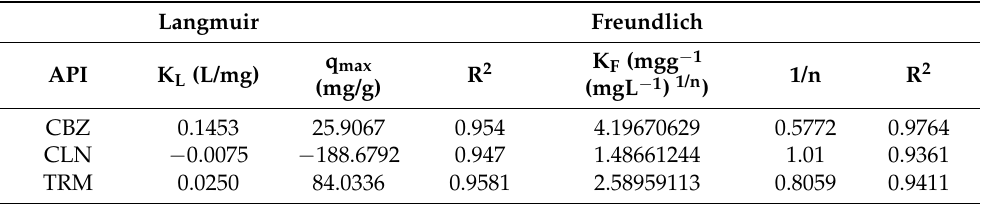
Table 5. Langmuir and Freundlich coefficients of adsorption isotherms and the correlation coefficients of the experimental data.